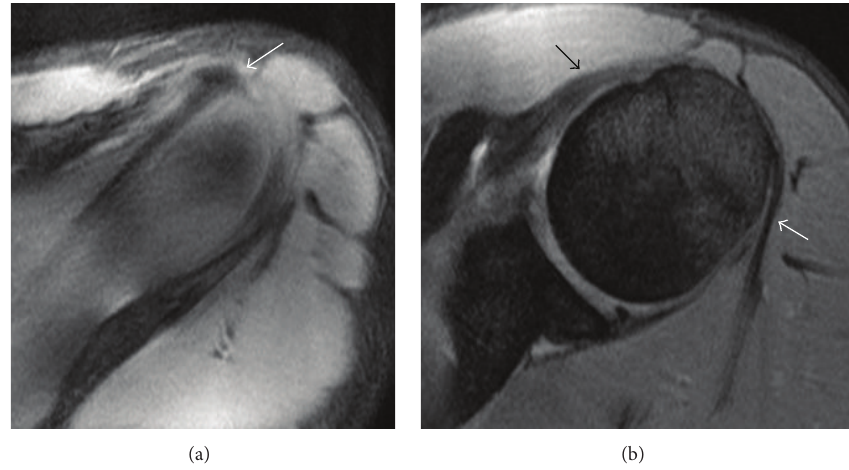
Figure 7: Axial DP FS SE MR images of the left shoulder (TR = 475; TE = 13.4; NEX = 2; EC = 1). (a) The supraspinatus tendon is visible, without any discontinuity (white arrow). (b) The subscapularis tendon (black arrow) and the infraspinatus tendon (white arrow) show normal thickness and hypointensity, without